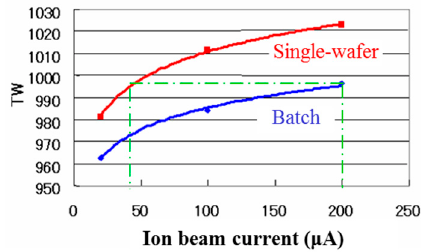
Figure 9. Therma wave (TW) value comparison between the single-wafer type and the batch type implanters [22]. Single-wafer type: MC3 (SMIT); batch type: GSD-HE (SMIT). Ion: P + , Energy: 90 keV, Dose: 2 × 10 13 cm − 2 .